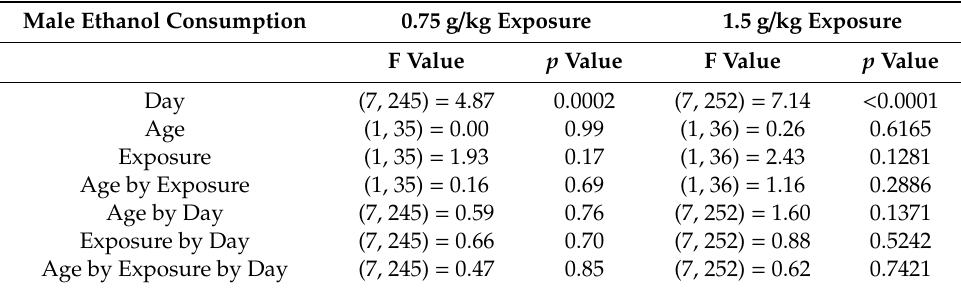
Table 2. Table for ANOVA results for male ethanol consumption